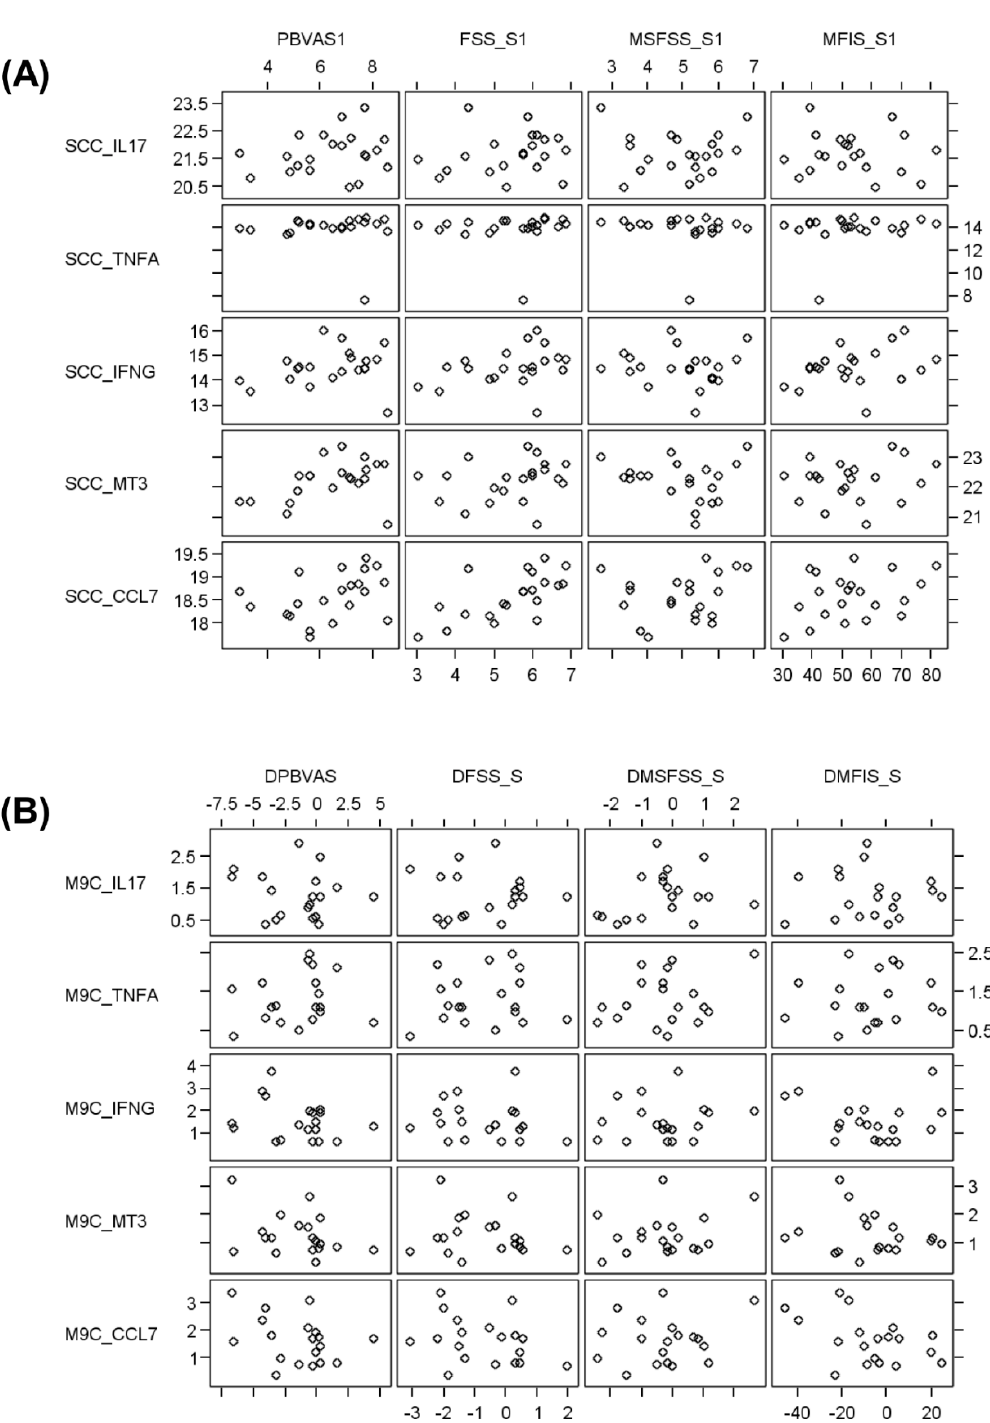
Figure 1. Correlation of Visual Analog Scale (VAS), Fatigue Severity Scale (FSS), MS-Fatigue Severity Scale (MS-FSS), and Modified Fatigue Impact Scale (MFIS) with immunological parameters at ( A ) baseline and ( B ) month 9. Note that the axes in panel ( A ) show the absolute results of the self-assessment scales ( x -axis) and the amplified cDNA ( y -axis), whereas the axes in panel ( B ) show the respective individual changes.